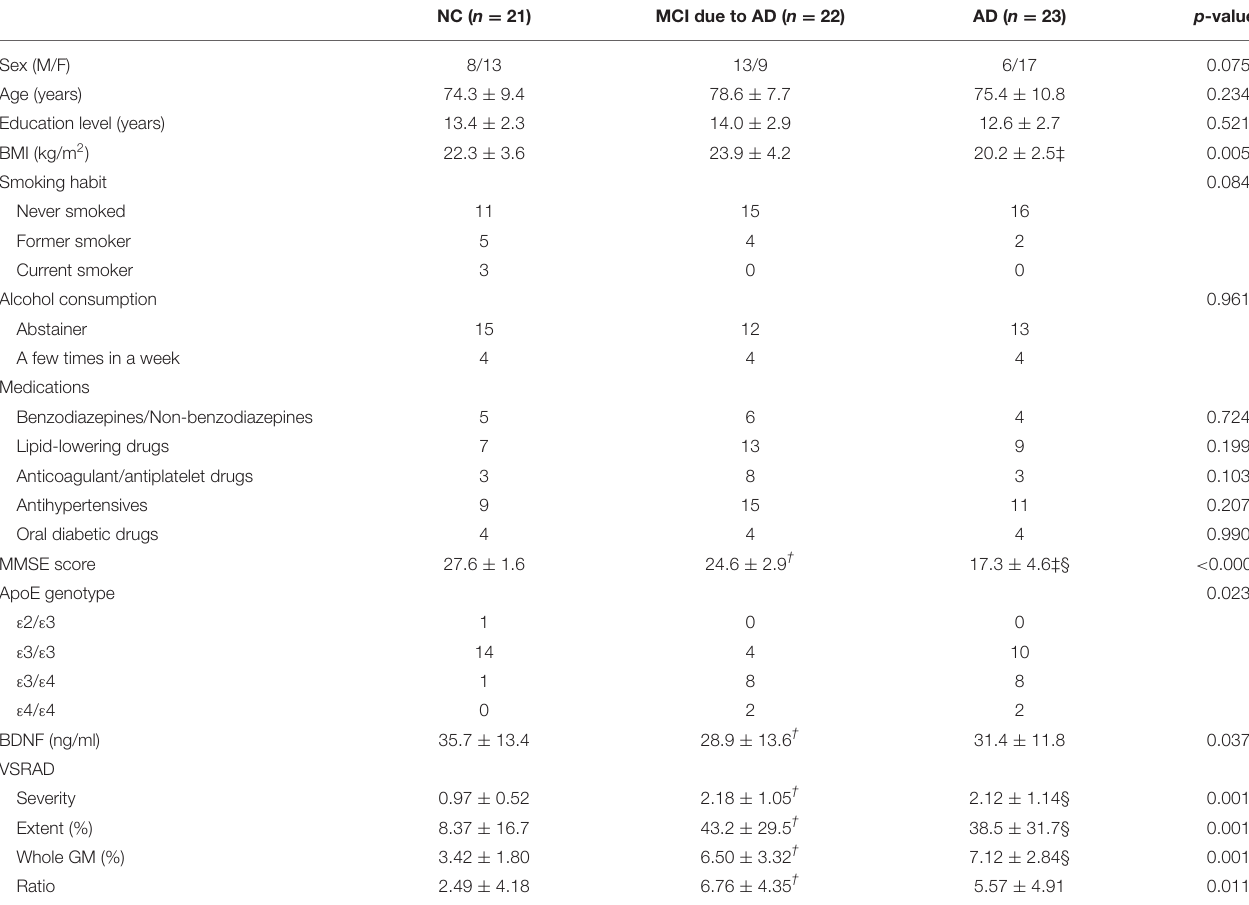
TABLE 1 | Characteristics of participants included in the serum